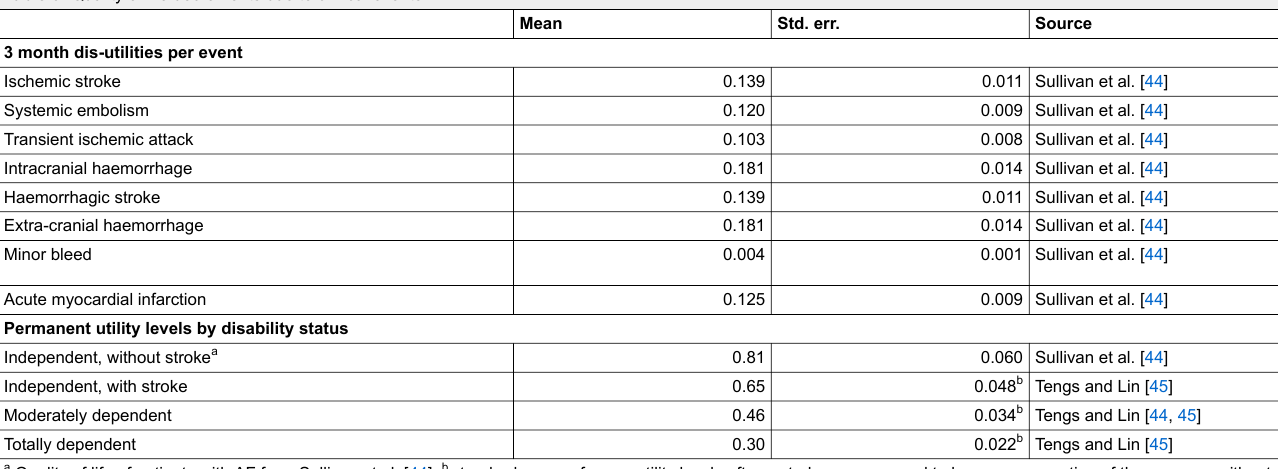
Table 3: Quality of life decrements due to clinical events.